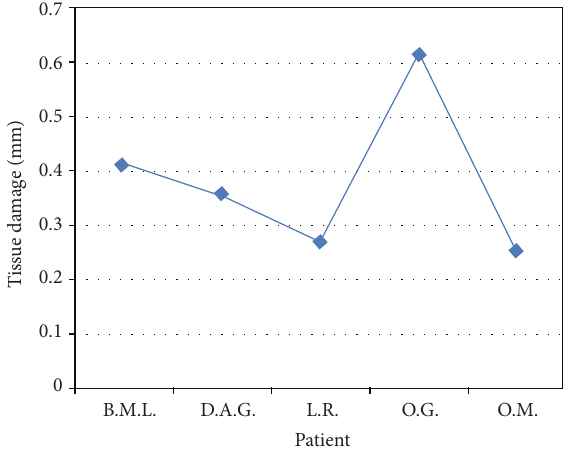
lichen planus demonstrated a damage average of 0.473 mm with a standard deviation of ± 0.105 mm (Figures 7 and 8; Table 4).